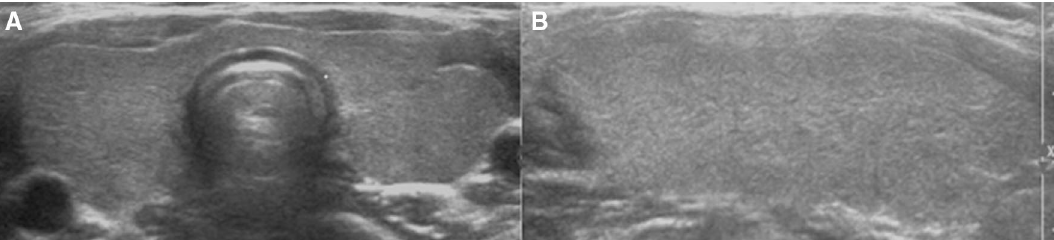
Figure 1. Transverse ( A ) and longitudinal ( B ) US images of G1: diffusely enlarged thyroid gland with normal echogenicity, similar to a normal thyroid gland and hyperechoic compared with the anterior strap muscle (asterisk) without